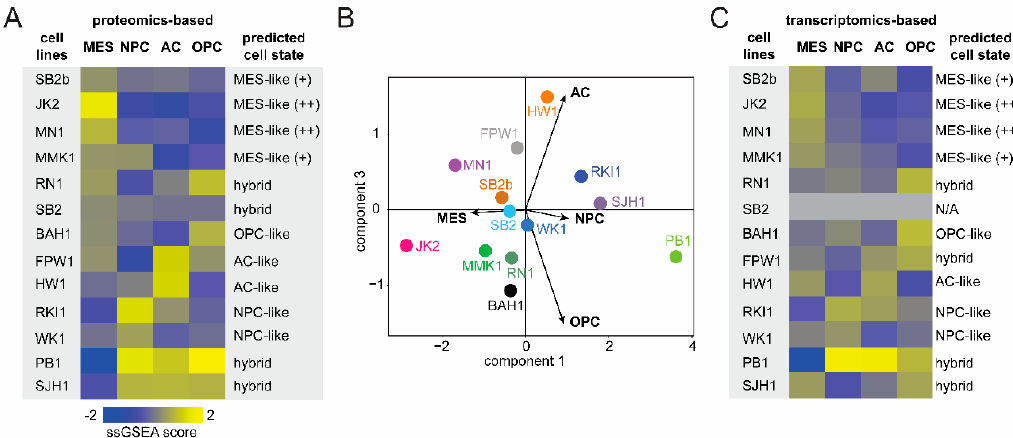
Figure 2. ssGSEA based cell-state scores ( A ) Heatmap of the z-scored ssGSEA scores of the thirteen cell line proteomes with predicted cell-states on the right. ( B ) PCA plot showing the distribution of the cell lines across the four cell-states. ( C ) Heatmap of the z-scored ssGSEA scores of the twelve cell line transcriptomes with predicted cell-states on the right. (Note: SB2 was not analysed by transcriptomics). Abbreviations: MES-like, mesenchymal-like; AC-like, astrocyte-like; OPC-like, oligodendrocyte progenitor cell-like; NPC-like, neural progenitor cell-like.